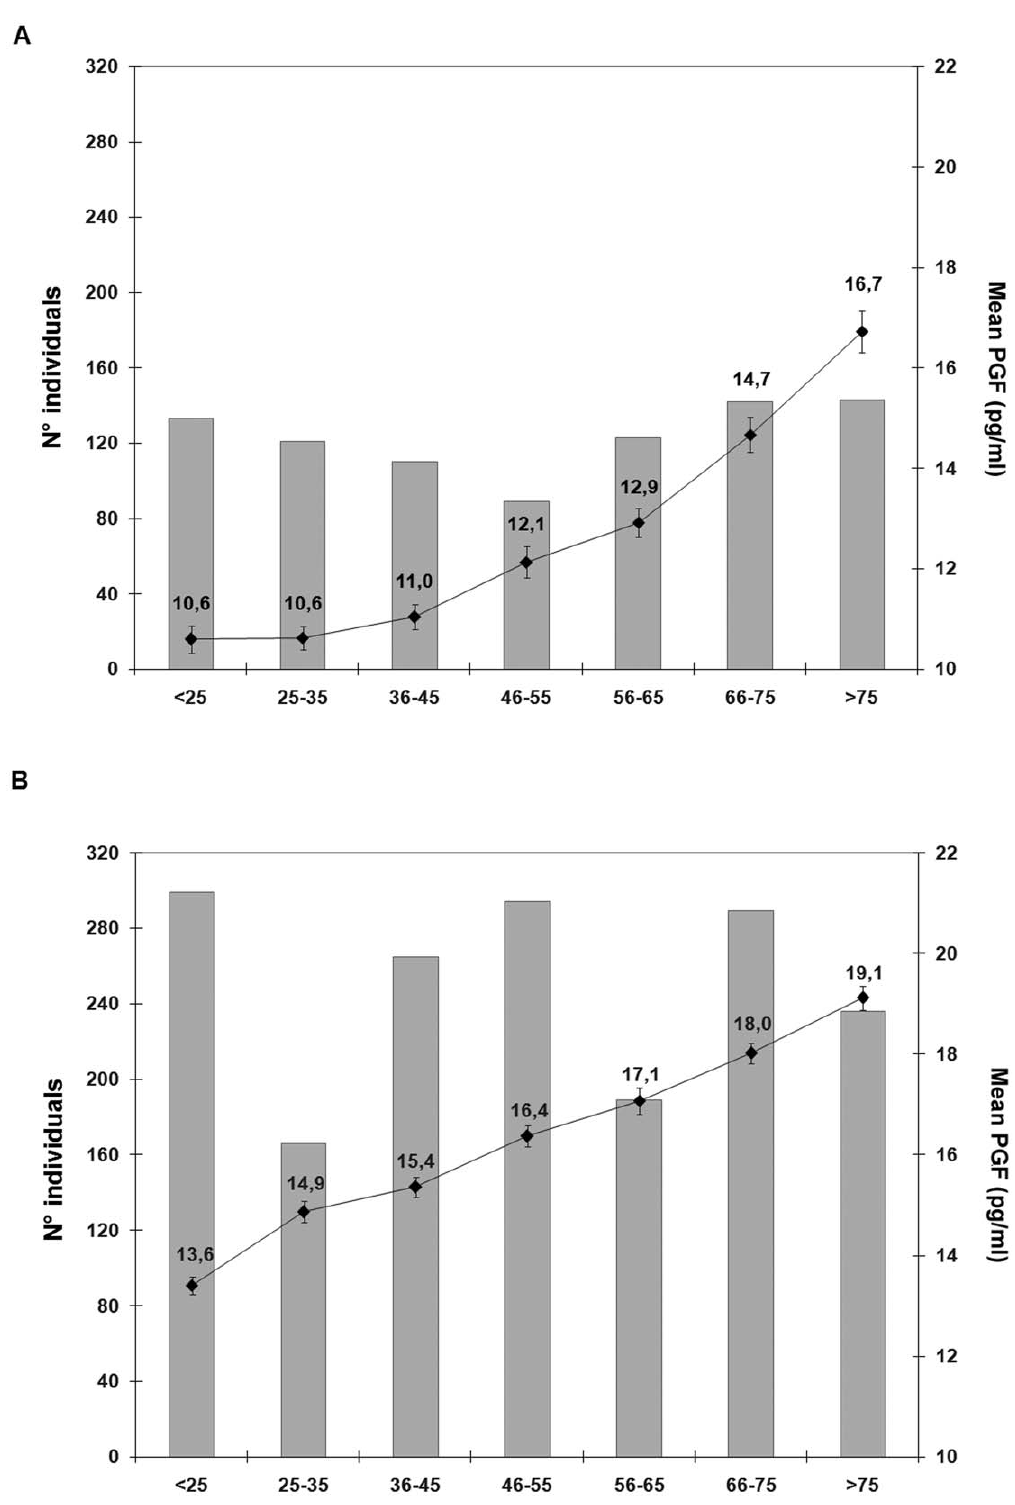
Figure 3. Cumulative effect of the environmental and genetic factors on the PGF levels. Mean PGF levels (right vertical axis) are shown as solid black dots connected by solid lines for categories of the cumulative risk score. The standard error is reported as error bar. The shaded bars show the distribution of the cumulative risk score in the whole population (left vertical axis) in the Cilento (A) and Denmark (B) sample.